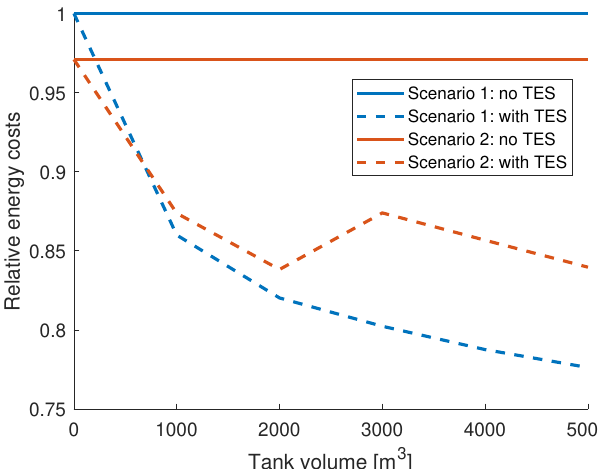
Figure 7. Reduction in peak heating costs as a function of tank size for scenarios 1 and 2 relative to the scenario with highest costs (scenario 1 without